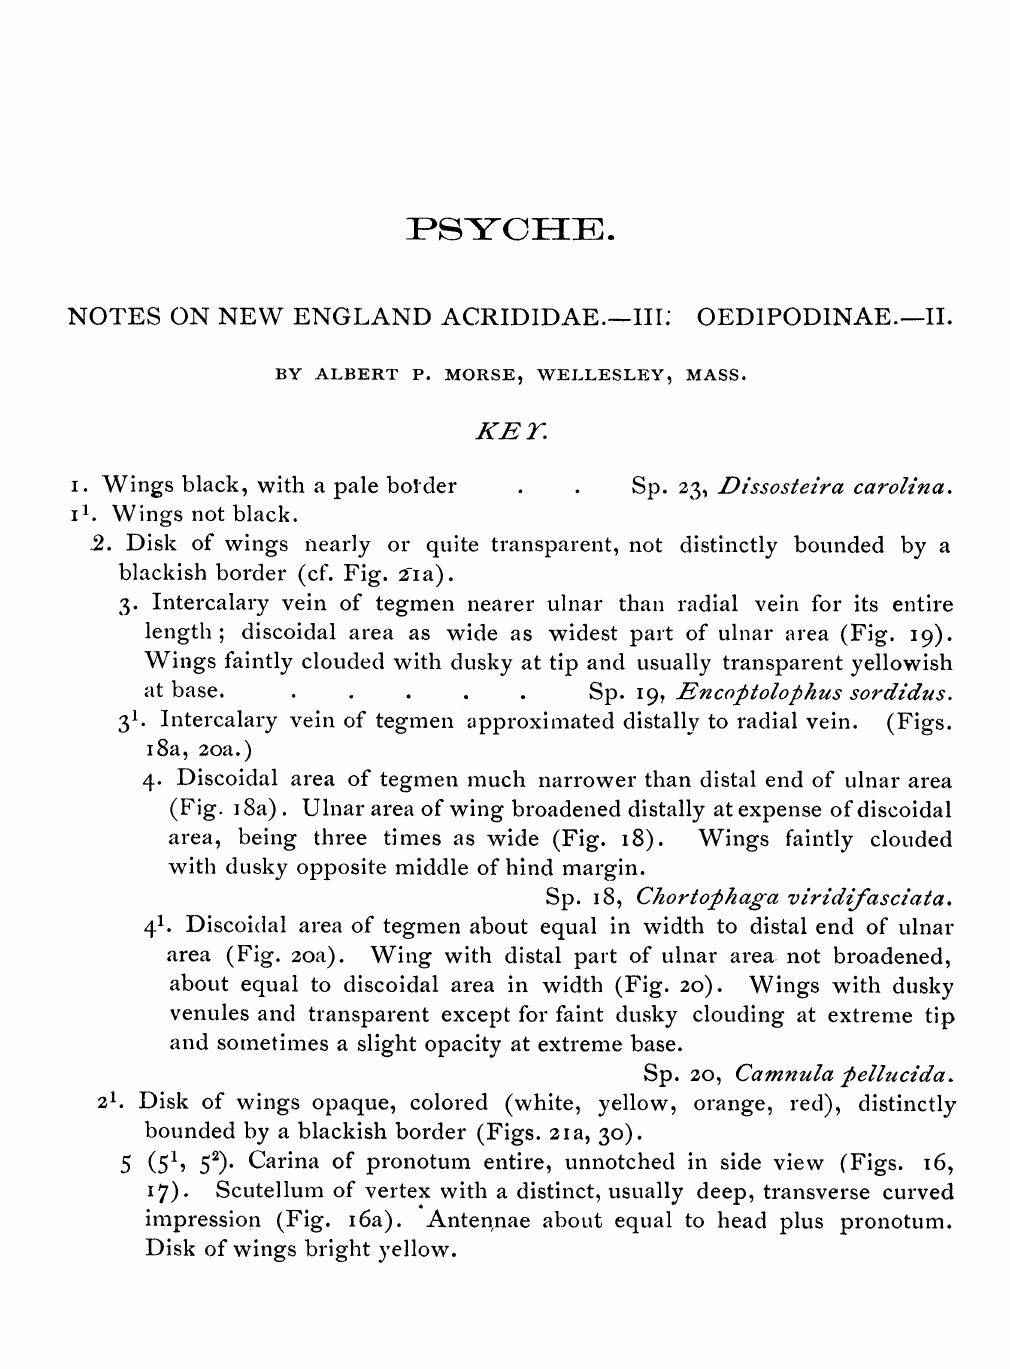
Wings with dusky Sp. 20, Camnula